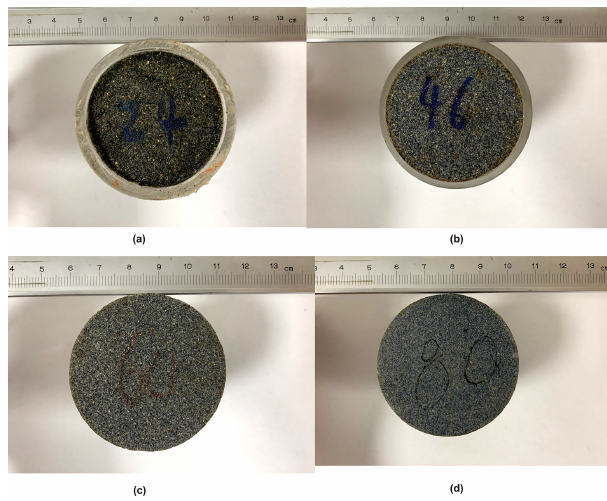
Figure 3. Permeable stones with different particle sizes: (a) 24 mesh size or 0.71mm, (b) 46 mesh size or 0.36mm, (c) 60 mesh size or 0.25mm and (d) 80 mesh size or